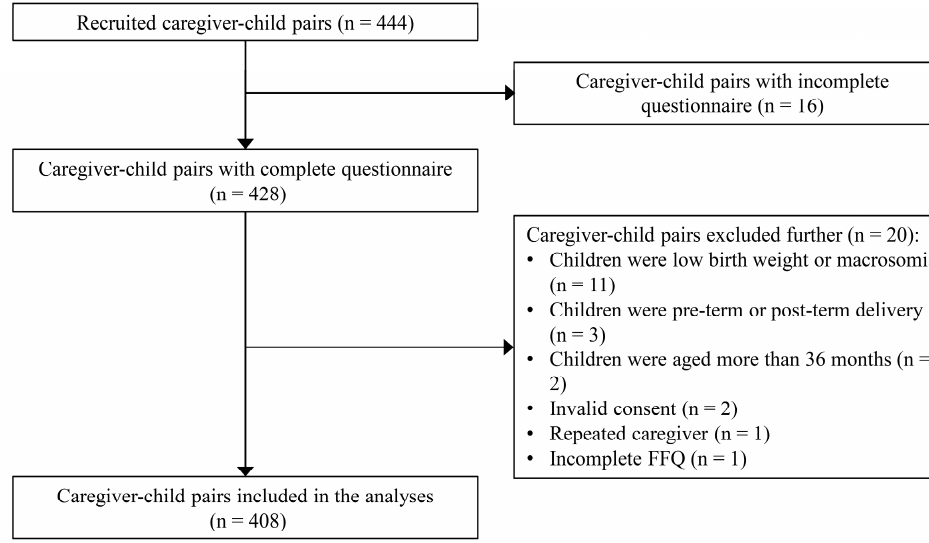
Figure 1. Flowchart of the participants. Table 1. Sociodemographic characteristics of the participants, caregivers’ feeding practices, and children’s emotional eating behaviours ( n = 408) .